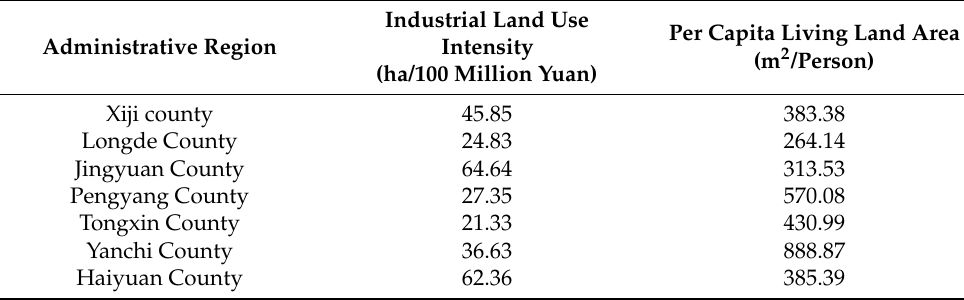
Table 1. Industrial and residential land use intensity in each county.